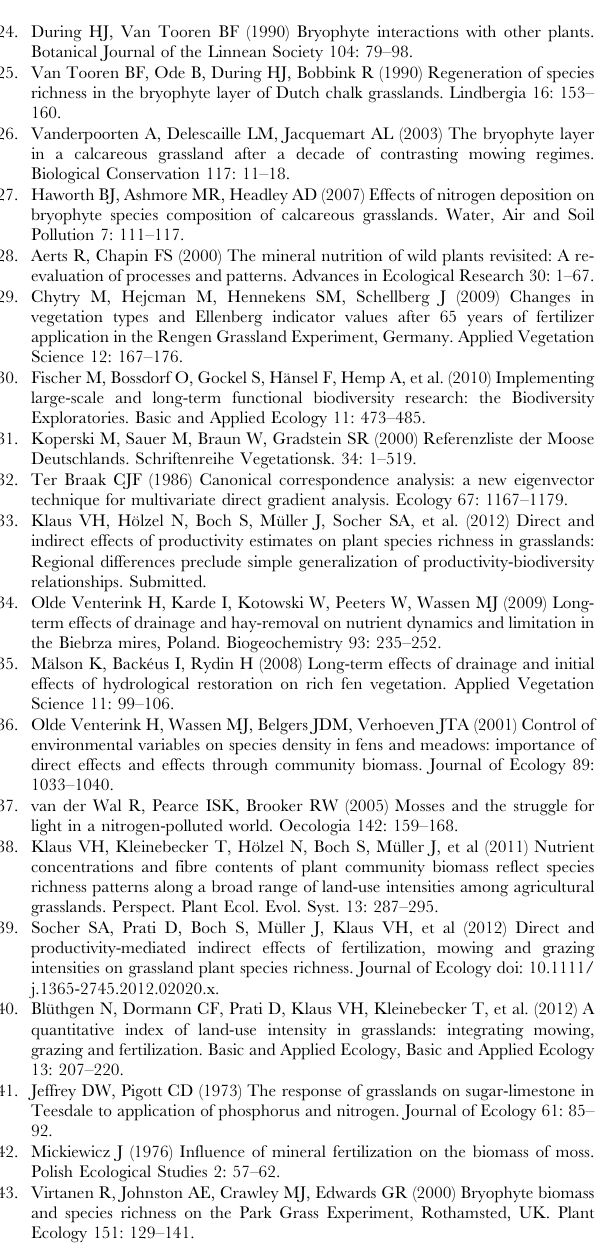
Table S1 Abbreviations and full names of bryophyte species in NMDS ordination. Abbreviations and full names of bryophyte species in NMDS ordination displayed in Figure